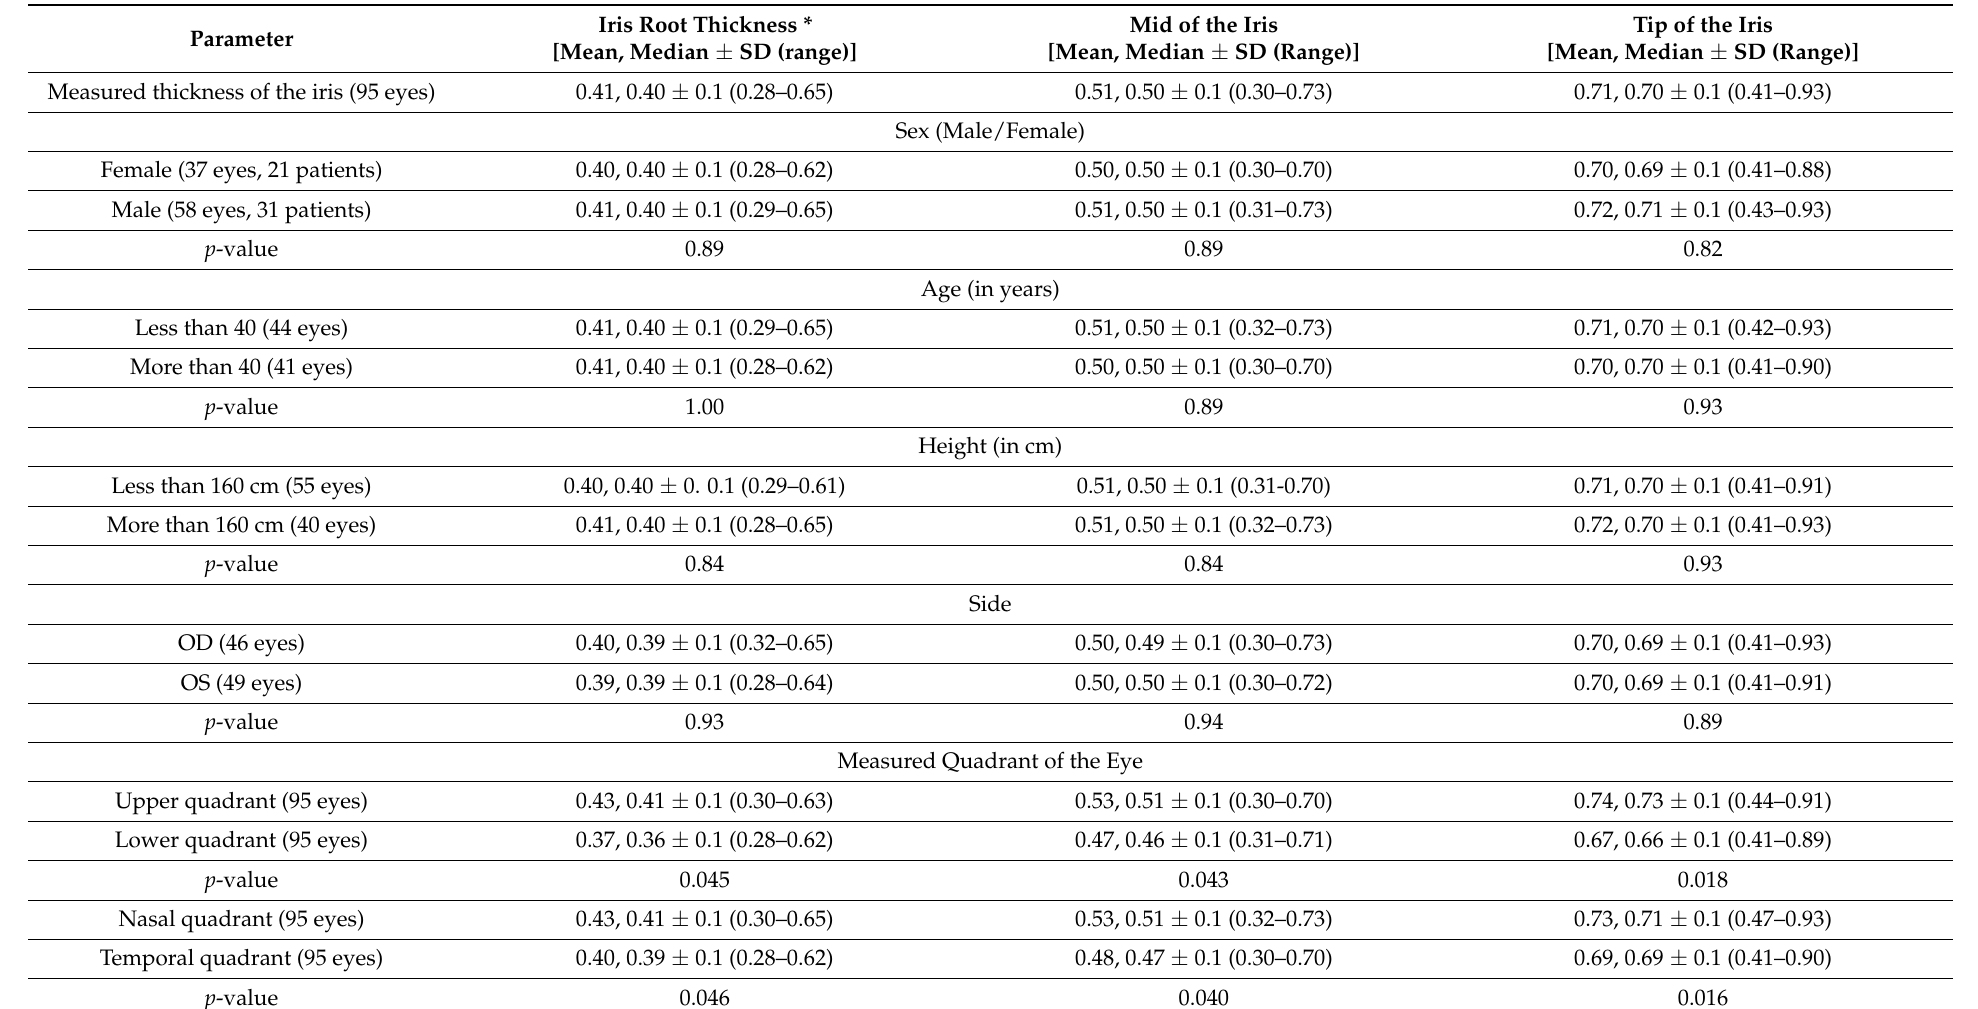
Table 2. Iris thickness (mm) comparison by sex, age, height, eye and